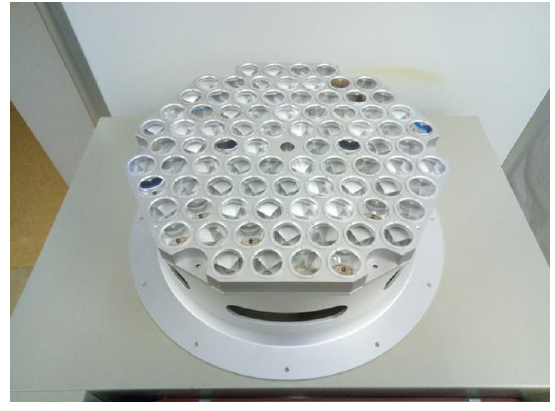
Figure 2. Laser retro-reflector array of Geostationary Earth Orbit (GEO)-Korea Multi-Purpose Satellite (KOMPSAT)-2B (GK-2B).